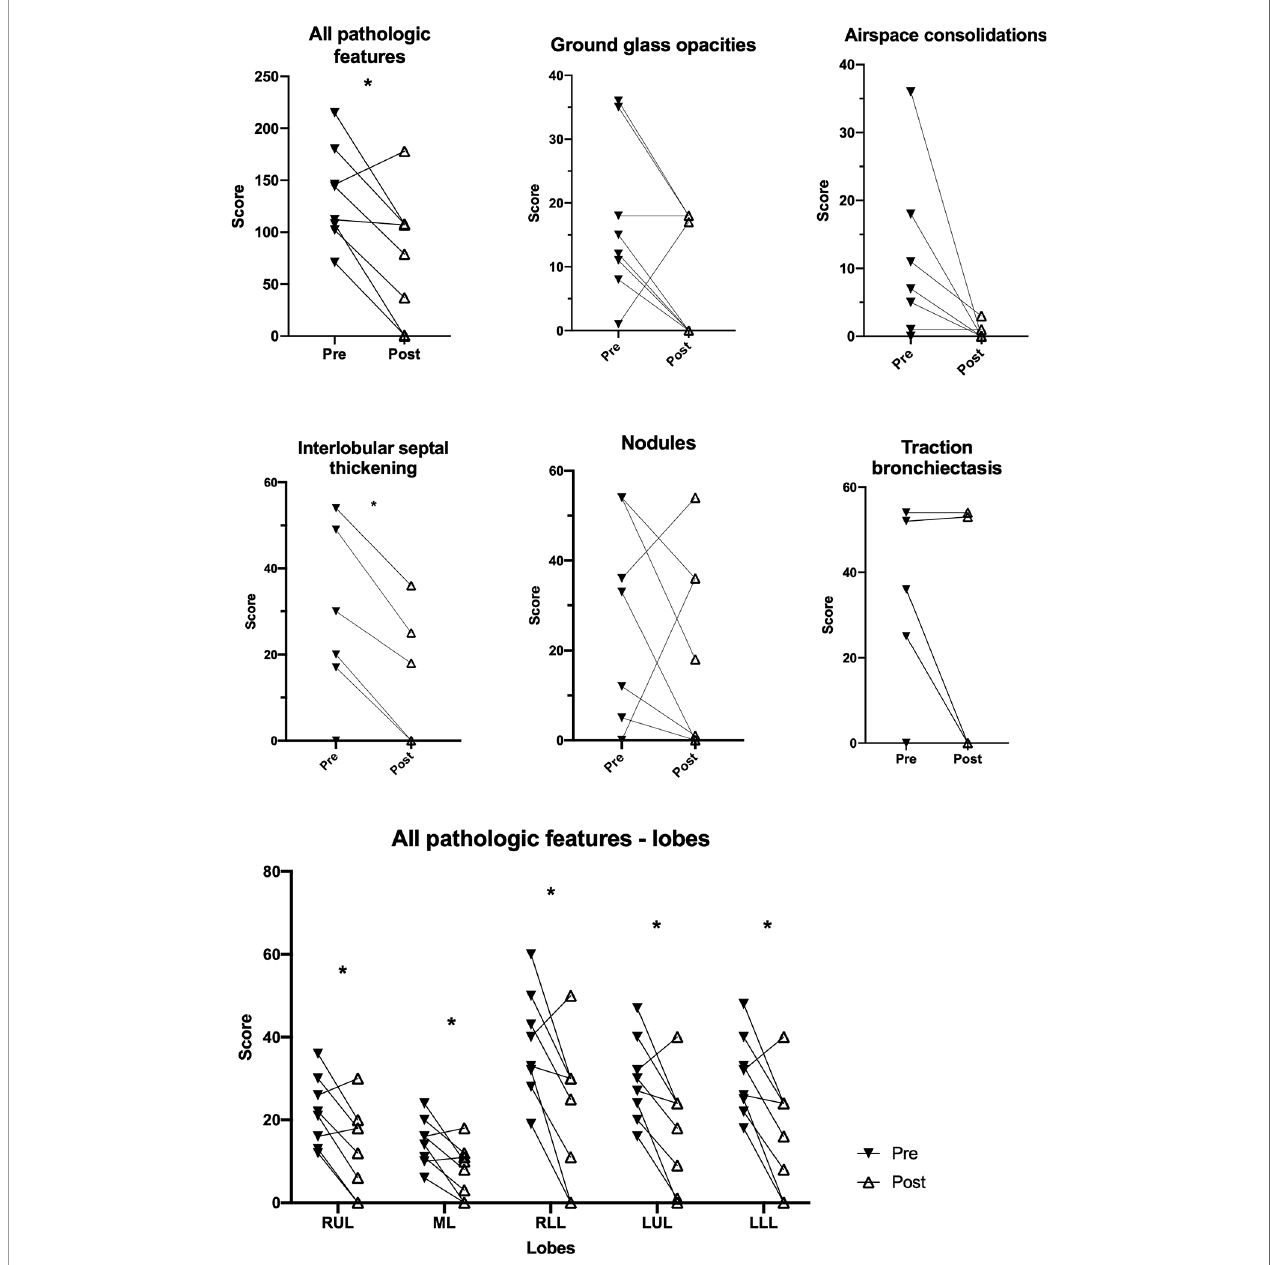
FIGURE 6 | Change in pathological features on pulmonary CT scans in granulomatous-lymphocytic interstitial lung disease (GLILD) patients before and after treatment with rituximab. RUL, right upper lobe; ML, middle lobe; RLL, right lower lobe; LUL, left upper lobe; LLL, left lower lobe. Median and interquartile range. *p <